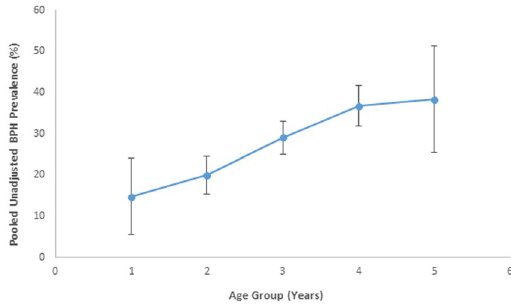
Figure 2. Unadjusted benign prostatic hyperplasia prevalence based across different age groups.